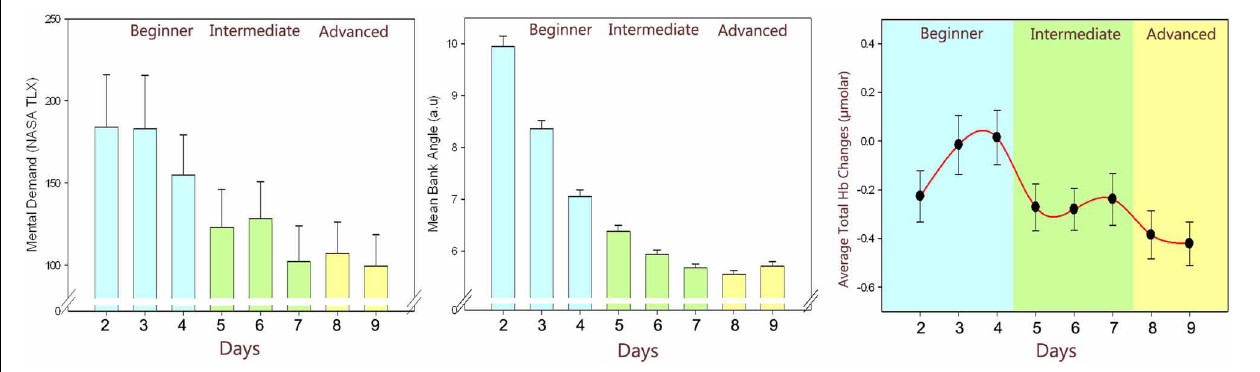
FIGURE 6 | Changes throughout the practice levels: Self-reported ratings: perceived mental effort as measured by NASA TLX (left), Behavioral performance: average error in banking angle (middle),